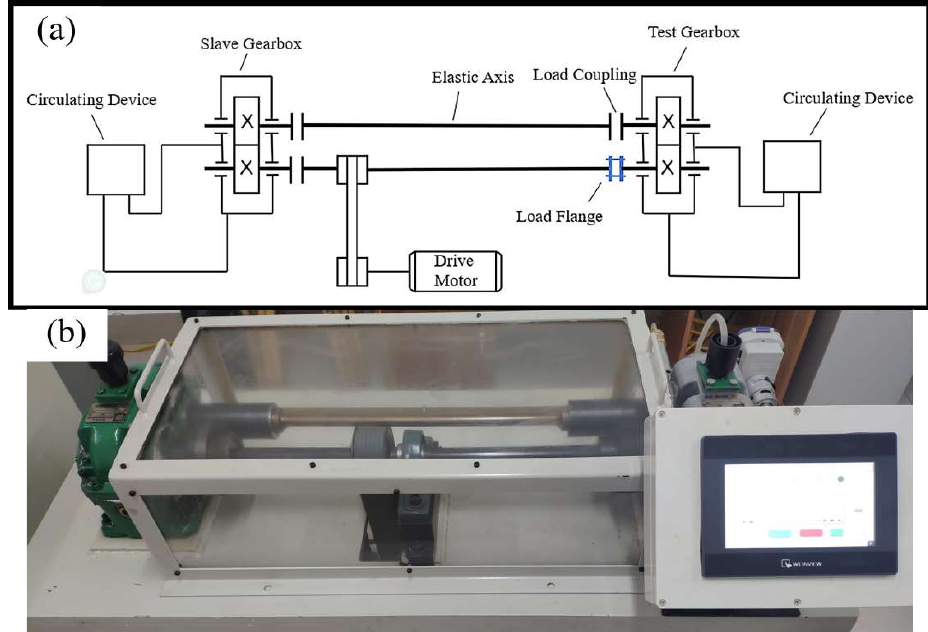
Figure 4. ( a ) Working principle diagram of the test platform, ( b ) experimental test bench.